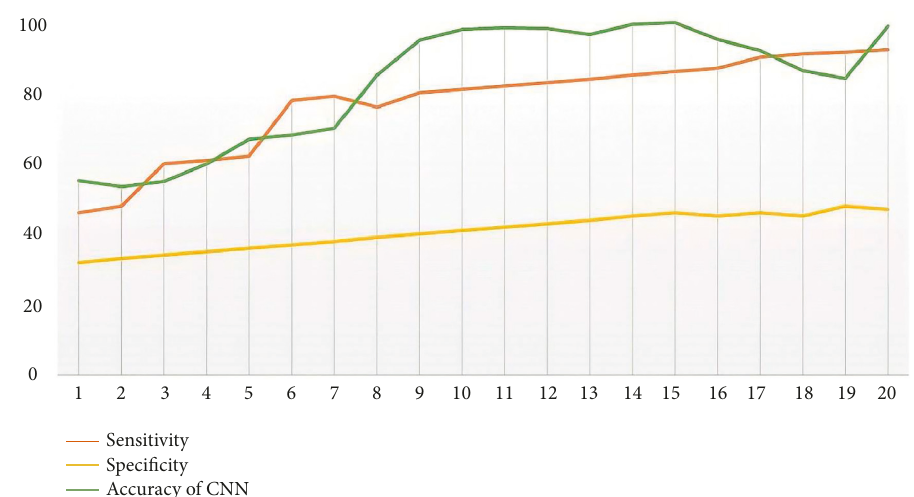
Figure 7: Graphical representation of accuracy, sensitivity, and